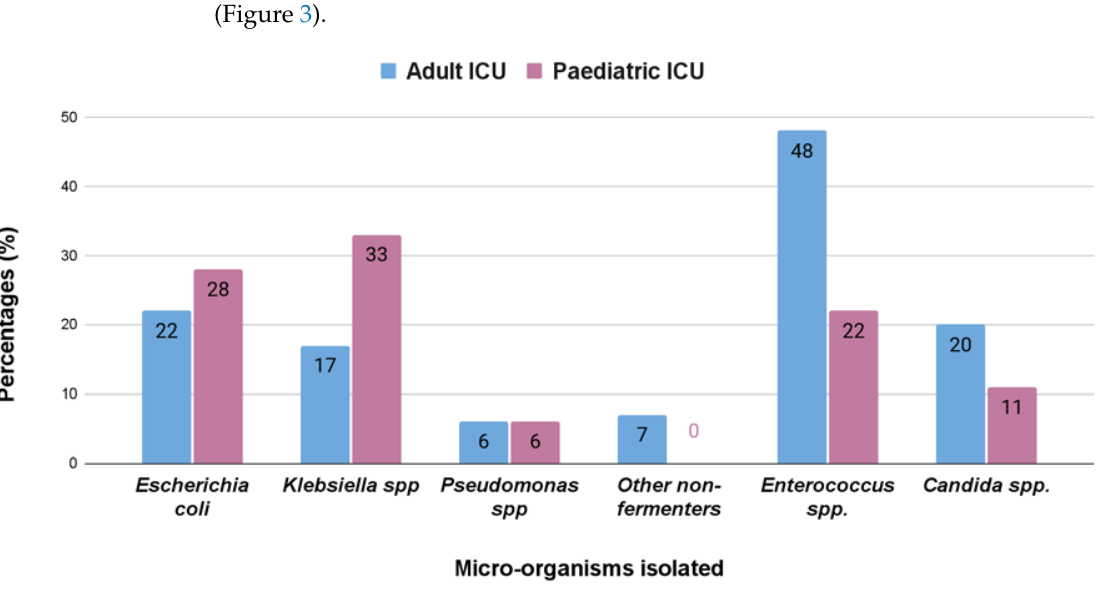
Figure 2. Percentage (%) of different bacterial isolates obtained from respiratory samples of the adult and pediatric intensive care units.